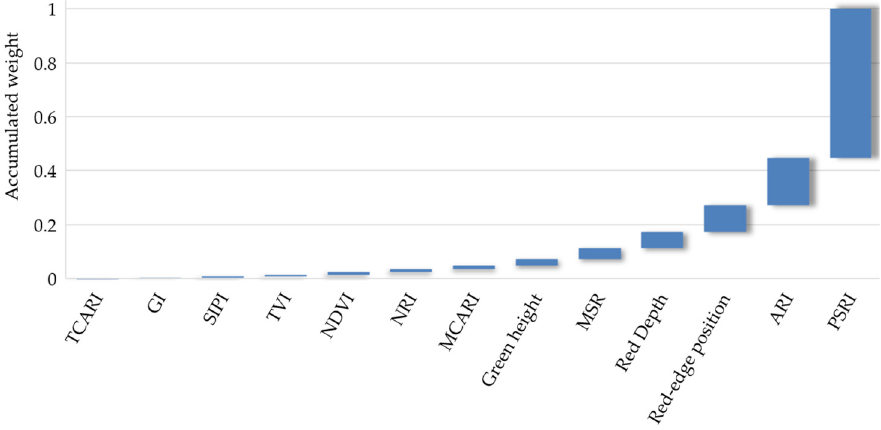
Figure 3. The relief weights of the spectral indices in the severely and slightly diseased categories. The height of each bar is the actual weight of the corresponding index, and the accumulated weight is denoted by the top of the bar.